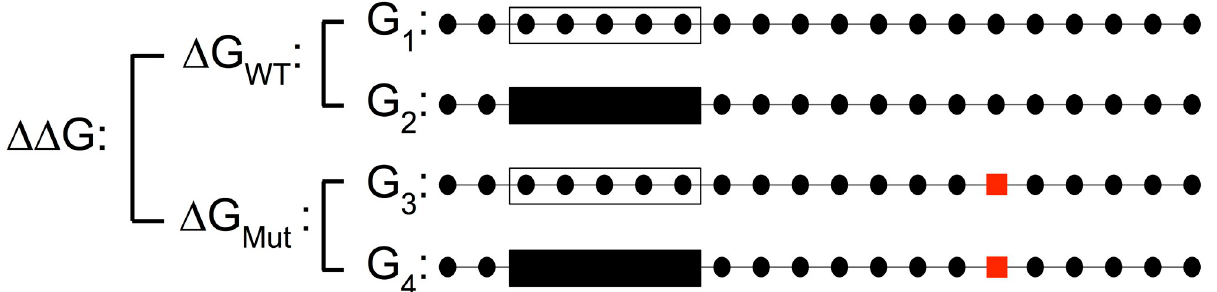
Fig 6. Possible configurations of a SNP and protein on RNA. The four different configurations of an RNA subject to sequence variation interacting with a protein: wild type sequence not bound by a protein, wild type sequence bound by a protein, mutant sequence not bound by a protein, or mutant sequence bound by a protein. Lines represent RNA backbones, and black dots represent bases. Transparent and opaque boxes represent unbound and bound protein binding sites, and red squares represent a change in nucleotide identity between the wild type and mutant sequences. Bases bound by a protein cannot base pair, but the base that differs between wild type and mutant